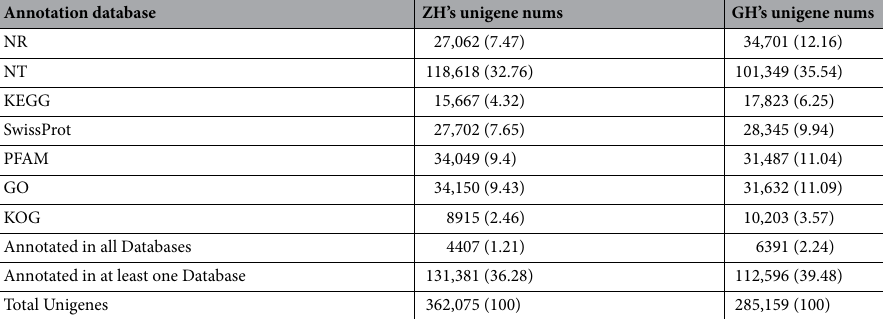
Table 2. Gene annotation success rate statistics. Annotation in NR, NT, KO, SwissProt, PFAM, GO, and KOG: the number and proportion of unigenes successfully annotated in seven databases. Annotated in all databases: the number and percentage of unigenes successfully annotated in all seven databases. Annotated in at least one database: the number and percentage of unigenes successfully annotated with at least one database.